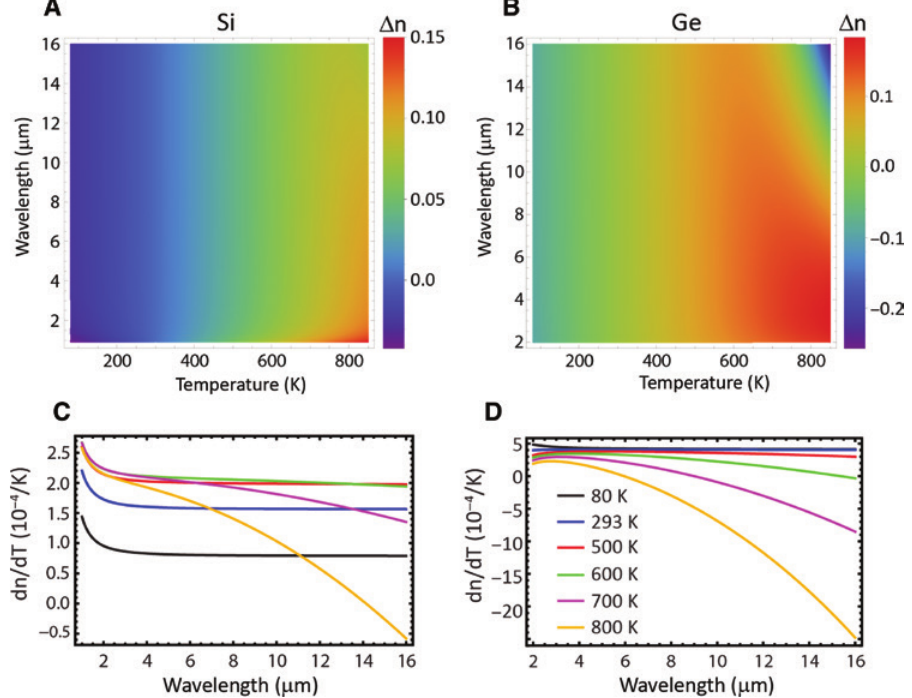
Figure 1: Temperature and wavelength dispersion of n and dn/dT in Silicon and Germanium. Thermally induced index shifts in Si (A) and Ge (B) as a function of wavelength (2–16 μ m) and temperature (80–850 K). (C) and (D) The chromatic dispersion of dn/dT at various temperatures in Si (C) and Ge (D). Each color plot corresponds to dn/dT at different temperatures as detailed in the legend of